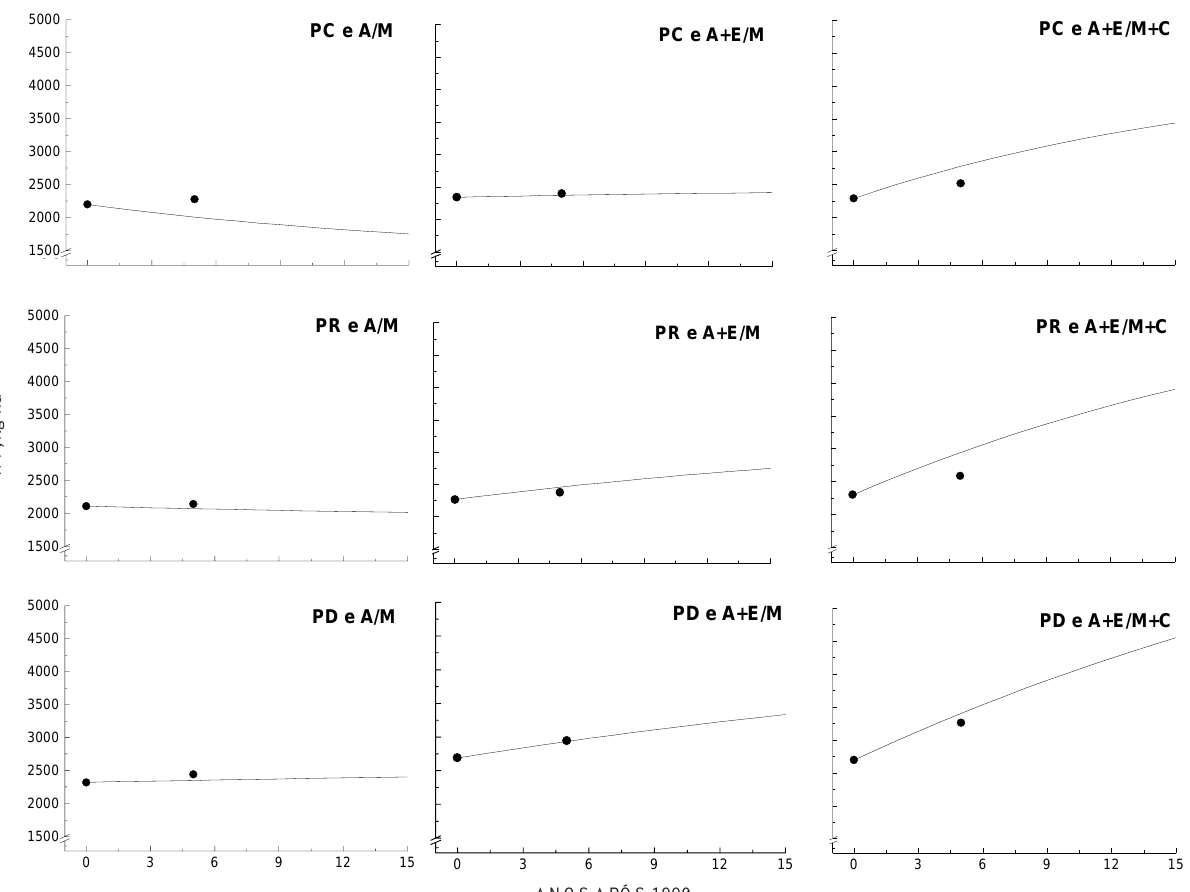
Figura 2. Simulação do efeito dos sistemas de preparo e de cultura sobre os estoques de nitrogênio total (NT) da camada de 0-17,5 cm do solo, durante quinze anos (1990-2005), por meio do ajuste do modelo N = N + (N - N ) e -K2.t . Linhas correspondem aos valores estimados pelo modelo e os pontos aos t e o e dados